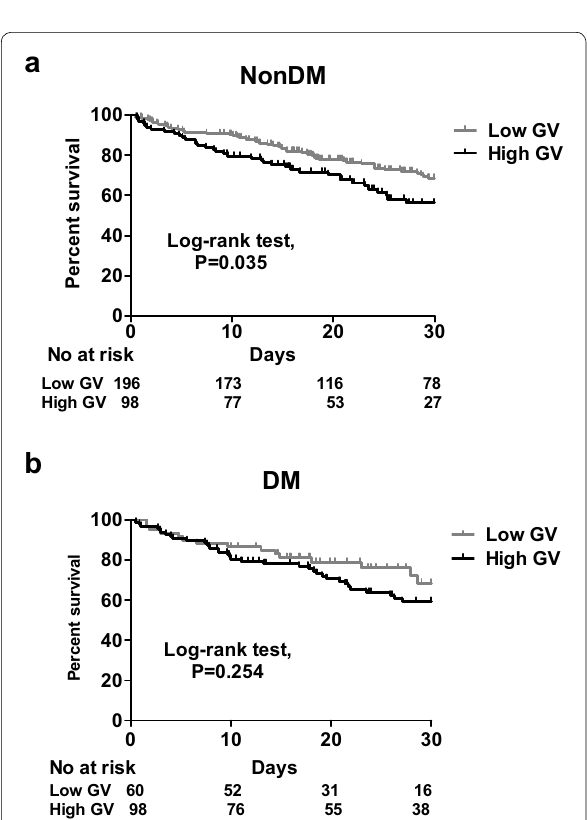
Fig. 3 Kaplan–Meier survival curves categorized by glycemic status in patients without ( a ) and with ( b ) DM. Low GV, MAGE MAGE >